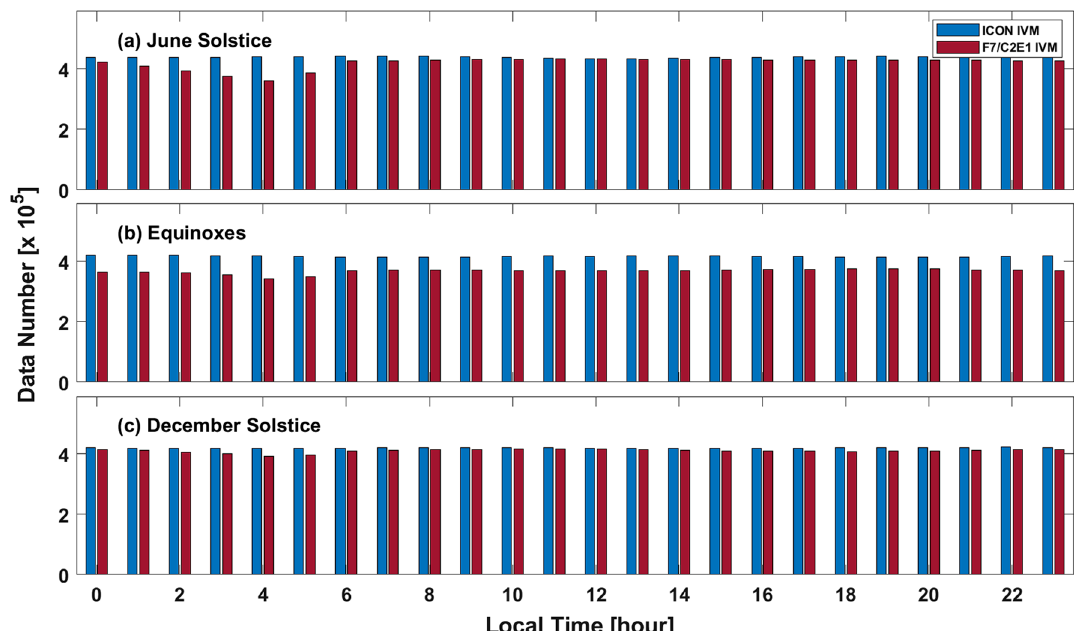
Fig. 2 Seasonal and local time distribution of data availability of F7/C2E1 and ICON during the solar minimum from December 2019 to November